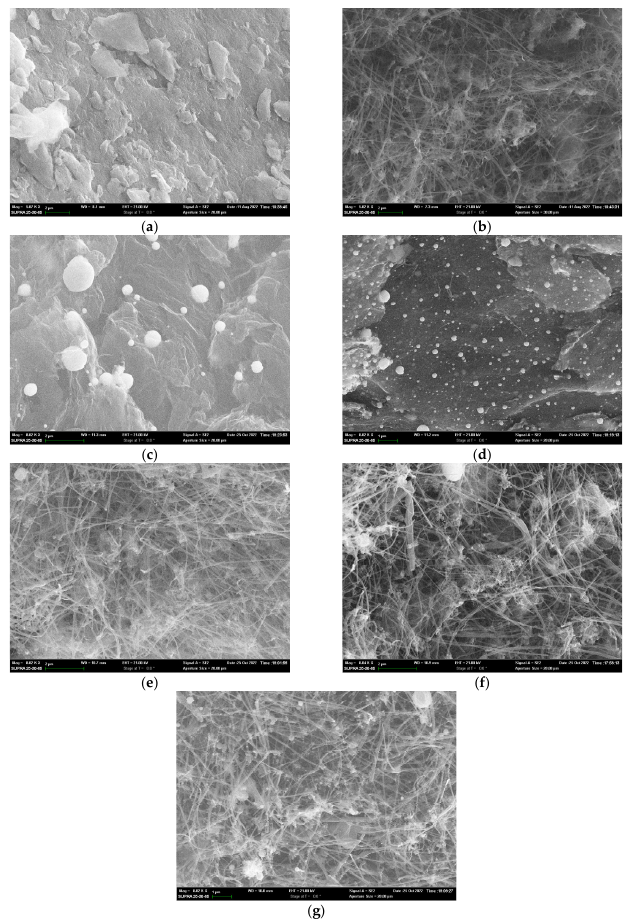
Figure 3. SEM photographs: ( a ) GO (magnification 5000 times); ( b ) MWCNT (magnification 5000 times); ( c ) GO_Ag 10% (magnification 8000 times); ( d ) GO_Ag 20% (magnification 8000 times); ( e ) MWCNT_Ag 10% (magnification 8000 times); ( f ) MWCNT_Ag 20% (magnification 8000 times); ( g ) MWCNT_Ag 10% Pd 10% (magnification 8000 times).